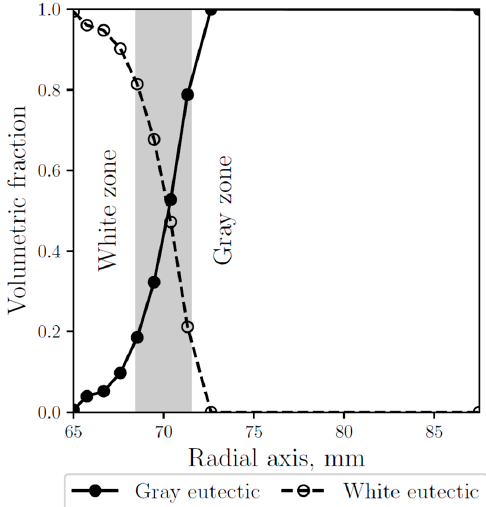
Figure 8. Simulated gray (continuous line) and white (dashed line) eutectic fractions along the radial axis. The gray area represents the experimentally observed transition zone.